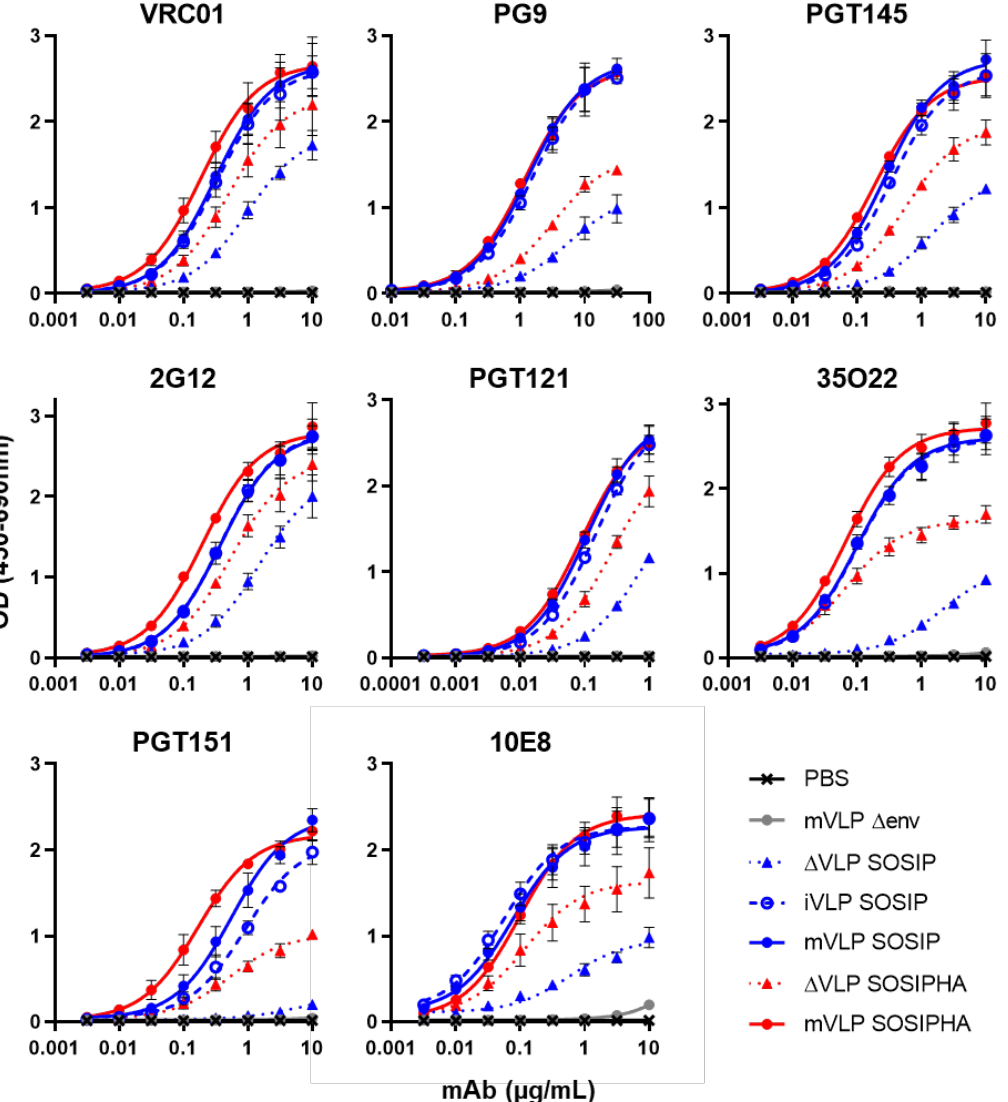
Figure 5. Antigenicity of single plasmid-expressed VLP immunogens: VLP ELISA binding curves of VRC01, PG9, PGT145, 2G12, PGT121, 35O22, PGT151, and 10E8 to Expi293F-produced ∆ VLPs and mVLPs bearing SOSIP or SOSIPHA Env, and iVLPs bearing SOSIP Env. A buffer-only control (PBS) and Expi293F-produced mVLP ∆ env particles were also assayed. 200 ng equivalent gp120/well (as determined by anti-gp120 Western blotting) was loaded for iVLP SOSIP, mVLP SOSIP and mVLP SOSIPHA. ∆ VLP loading was volume-equalized to the highest volume used for their equivalent VLP-associated Env (SOSIP or SOSIPHA). mVLP Δenv loading was p24-equalized to mVLP SOSIP p24 as determined by p24 ELISA. Values represent the mean and SEM of 3 independent experiments.